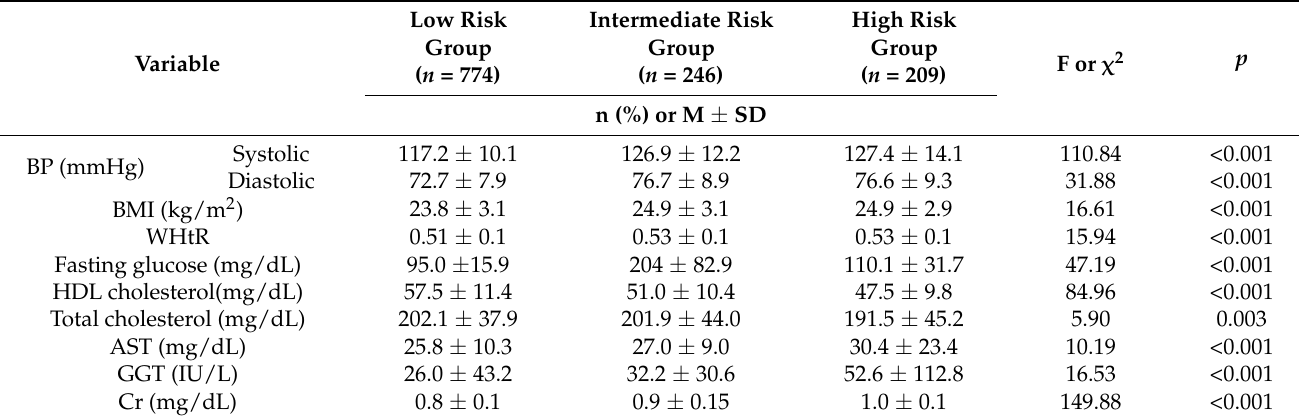
Table 2. Differences in hematologic tests according to FRS ( N =